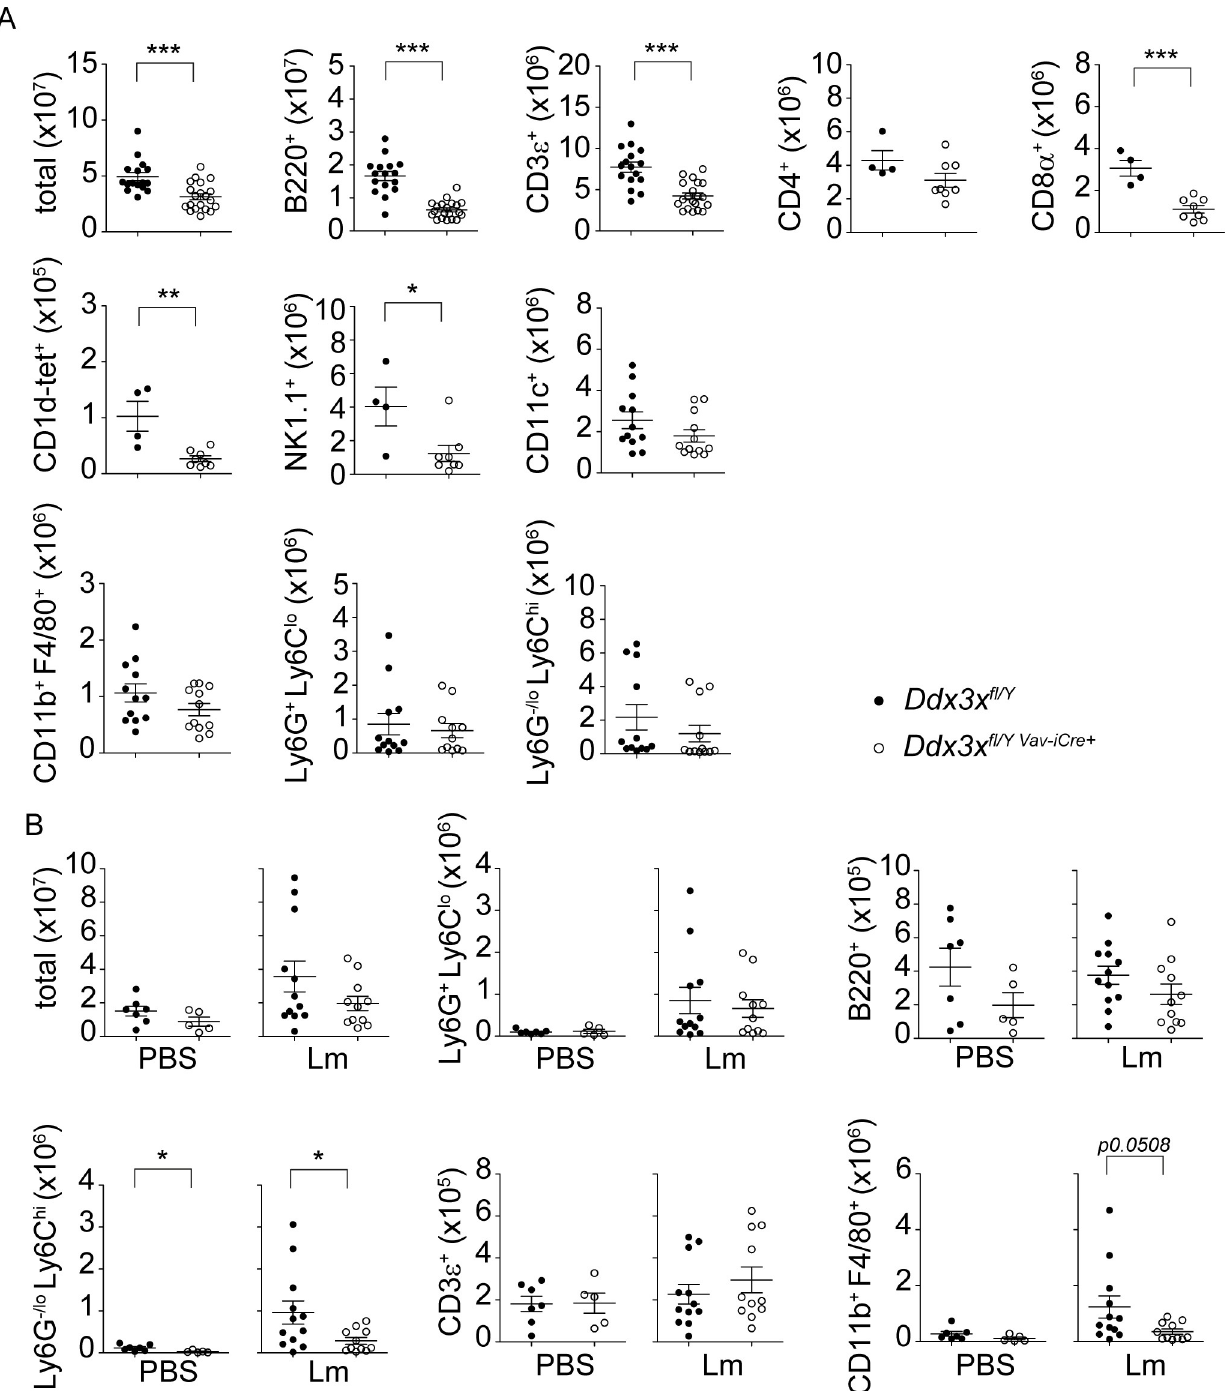
Fig 6. Ddx3x fl/y Vav-iCre mice show alterations in spleen and peritoneum upon Listeria monocytogenes infection. A Ddx3x fl/y and Ddx3x fl/y Vav-iCre mice were infected intraperitoneally with 1x10 5 CFU Listeria monocytogenes (strain EGD) for 24 h, spleens were isolated, homogenized and stained with the indicated surface markers, followed by flow cytometry. Total cell numbers per organ are shown (n = 16 for Ddx3x fl/y and 20 for Ddx3x fl/y Vav-iCre mice for total, B220 + and CD3 + cells, analyzed in 5 independent experiments; n = 4/8 for CD4 + , CD8 + and CD1d-tetramer + cells, all pre-gated on CD3 + , analyzed in 2 independent experiments; n = 4/8 for NK1.1 + cells (pre-gated on CD3 - ), analyzed in two independent experiments; n = 12/12 for CD11c + , CD11b + F4/80 + cells, analyzed in 3 independent experiments; n = 12/12 for Ly6G + Ly6C -/lo and Ly6G lo Ly6C hi cell populations, both pre-gated on CD11b + and analyzed in 3 independent experiments). B Ddx3x fl/y mice and Ddx3x fl/y Vav-iCre mice were infected intraperitoneally with 1x10 5 CFU L . monocytogenes (strain EGD) for